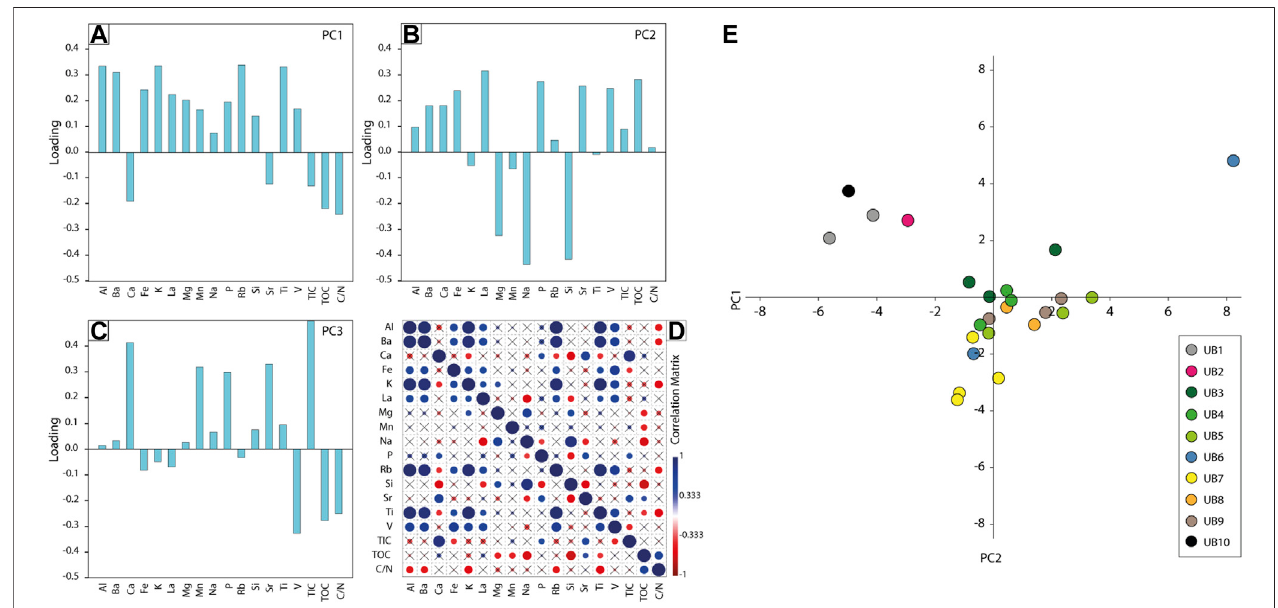
FIGURE 6 | Results of the statistical analysis. (A – C) Loadings of chemical components representing their in fl uence on the computed principal components (PC1 – PC3). (D) Correlation matrix showing the relation of the chemical components to each other. Blue indicates a positive correlation, while red shows an anticorrelation. The size of the circles is determined by the intensity of correlation. (E) Plot illustrating the impact of PC1 and PC2 on the lithological units.